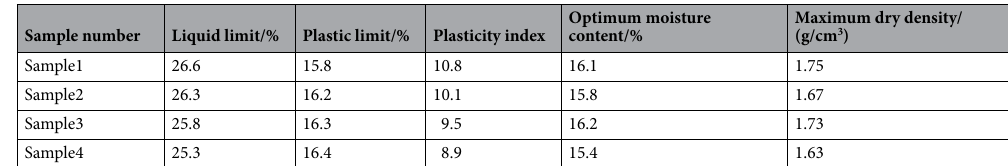
Table 4. Basic physical parameters of artificial